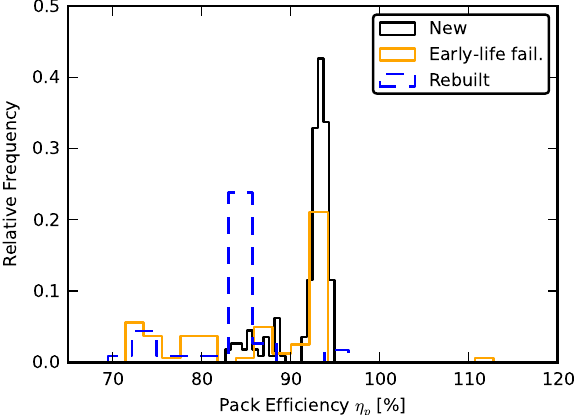
Figure 16. Overlaid coulombic efficiencies for the three